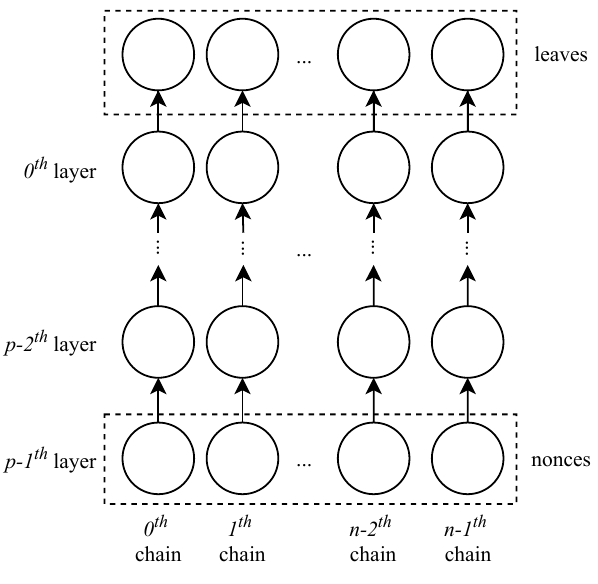
Figure 5. Hash chain